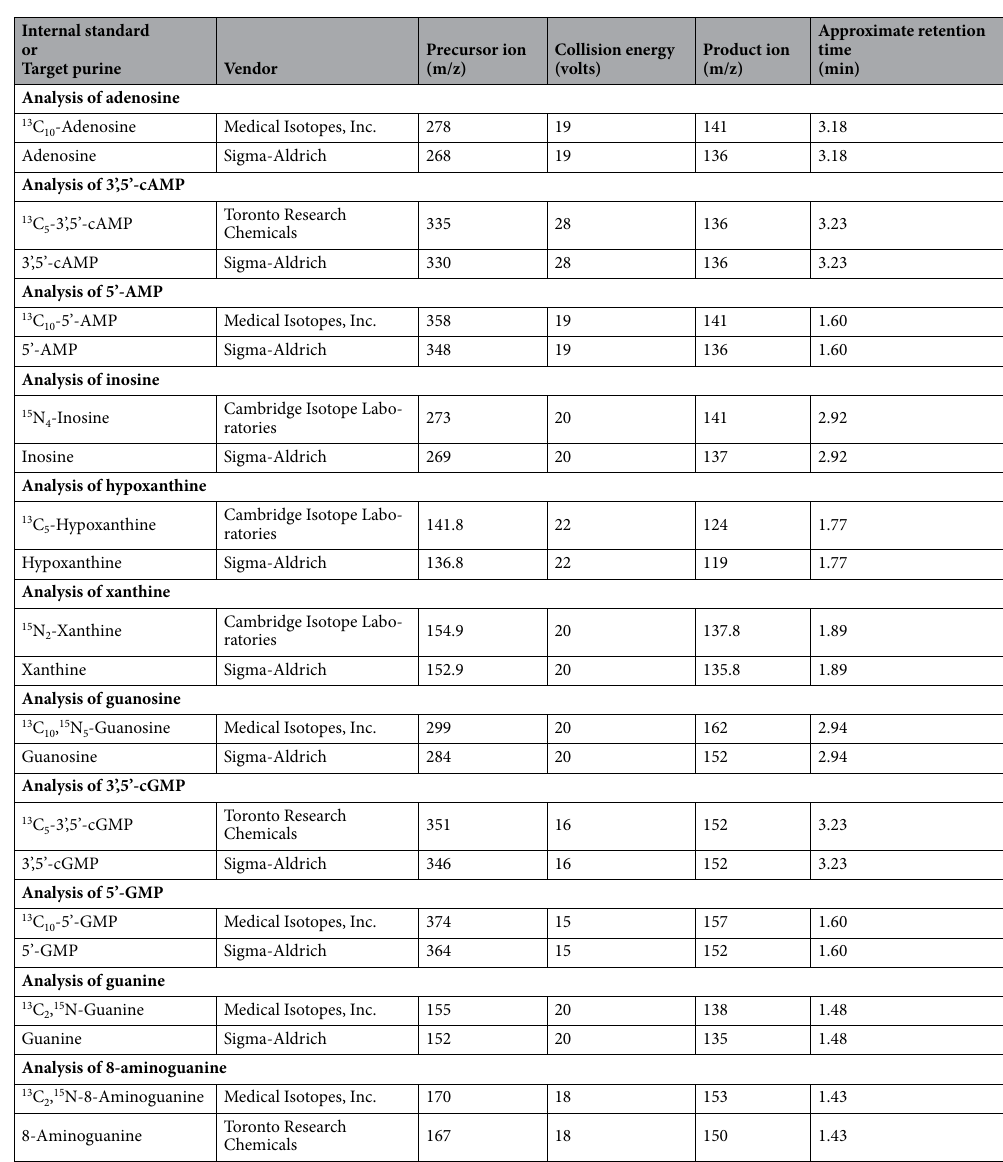
Table 1. Summary of UPLC-MS/MS